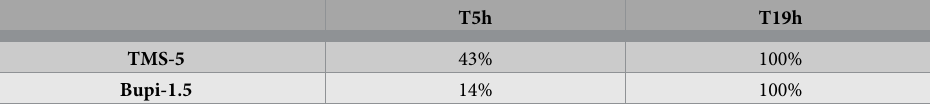
Table 1. Animals with ceased heart rates after 5- & 19-h immersions.